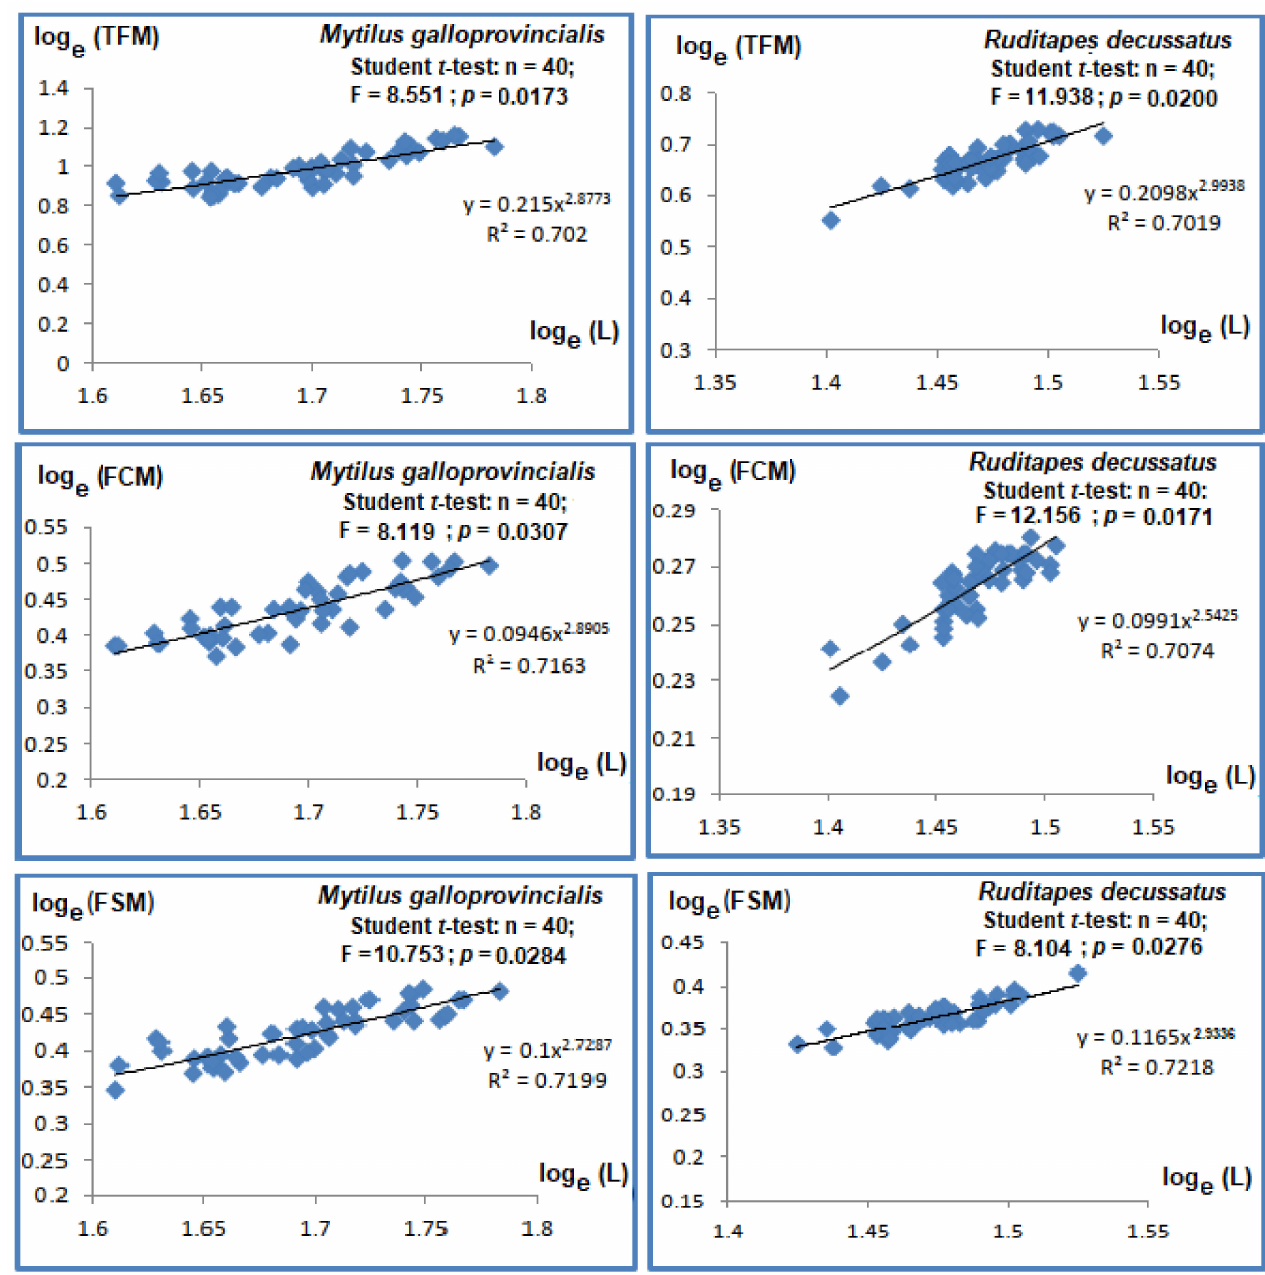
Figure 3. Regressions relating length and masses in bivalve species Mytilus galloprovincialis and Ruditapes decussatus . Total Fresh Mass (TFM); Fresh Chair Mass (FCM); Fresh Shell Mass (FSM), Length